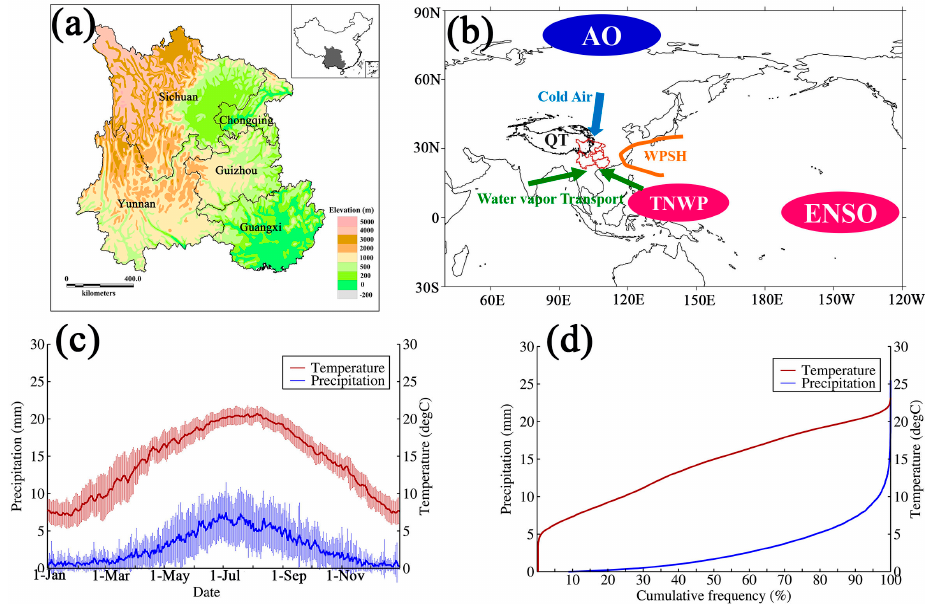
Figure 1. ( a ) Topography of Southwest China (SWC) and its geographic location in China (top right). ( b ) Schematic diagram of the influential atmospheric factors related to droughts in SWC [2]. TNWP, ENSO, WPSH, AO and QT stand for the tropical Northwest Pacific, El Niño Southern Oscillation, Western Pacific Subtropical High, Arctic Oscillation, and the Qinghai–Tibet Plateau, respectively. ( c ) Temporal evolution of mean daily observed precipitation and temperature (1979–2014) averaged over SWC. Thick lines represent daily values, while light shadows stands for one standard deviation. ( d ) Cumulative frequency distribution of all daily precipitation and temperature (1979–2014) averaged over SWC.